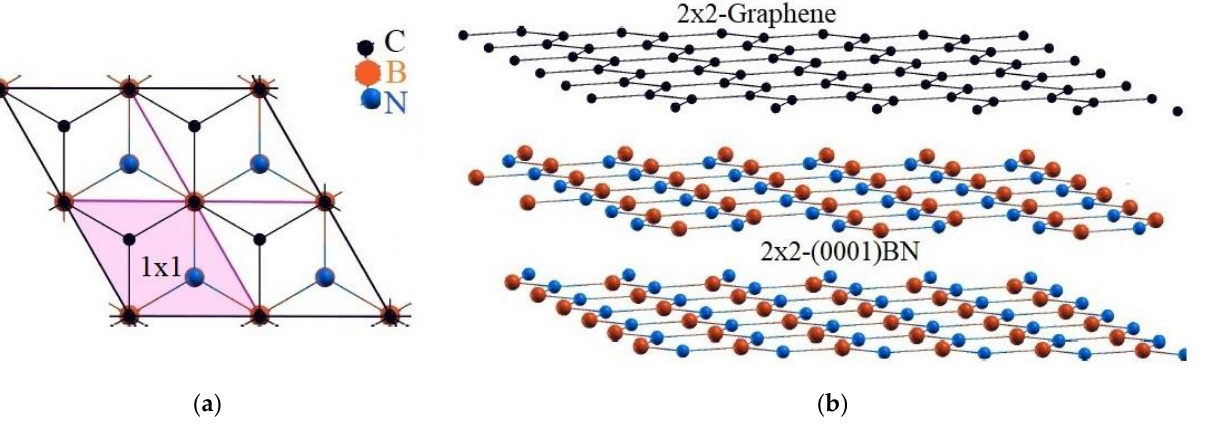
Figure 1. Representation of a 2 × 2-graphene/2 × 2-(0001)-BN cell. ( a ) Top view and ( b ) lateral view.